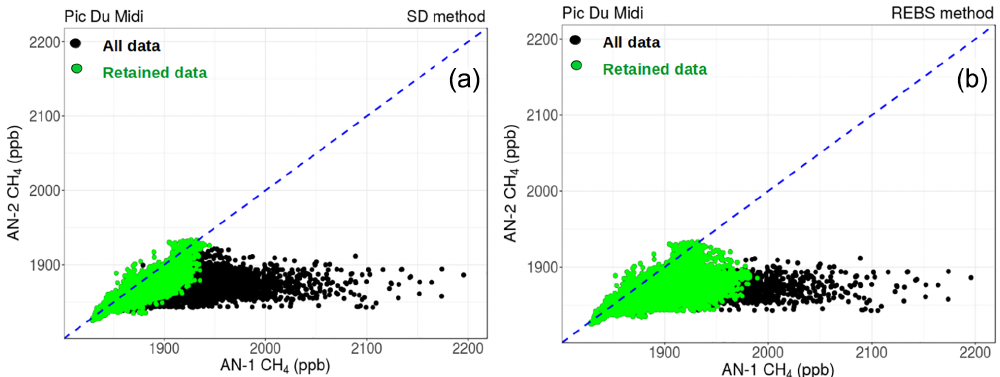
Figure 5. Plots of CH 4 measurements of AN-1 against AN-2. All data are in black, and the green points represent the retained data using SD method in panel (a) and REBS method in panel (b) .